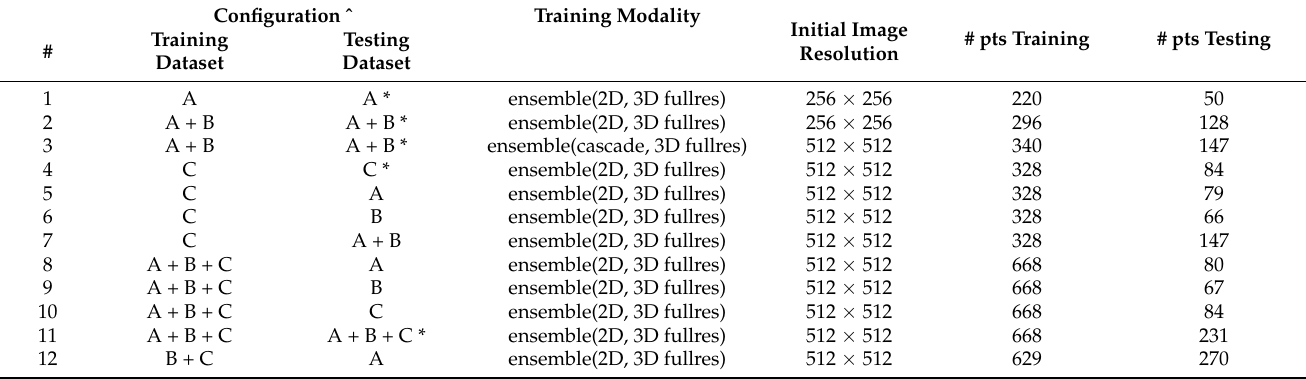
Table 1. Investigated combinations of the three datasets for the training and testing of nnU-Net. Configuration